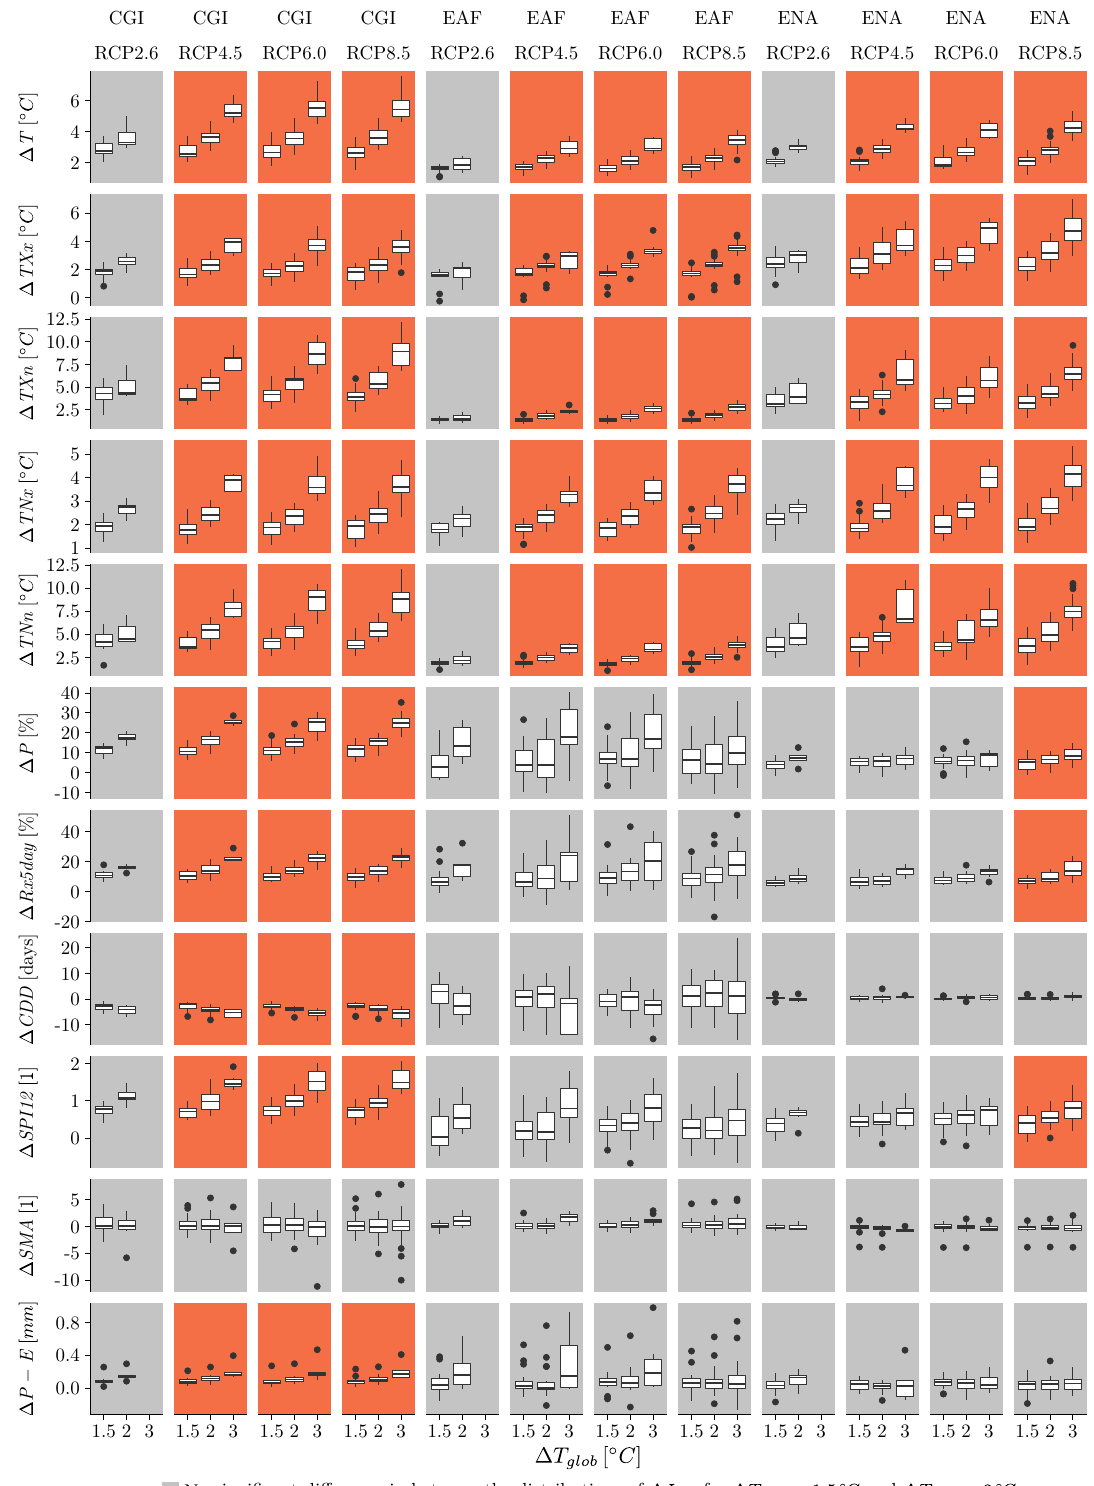
Figure A2. Like Fig. A1 but for SREX regions CGI, EAF, and